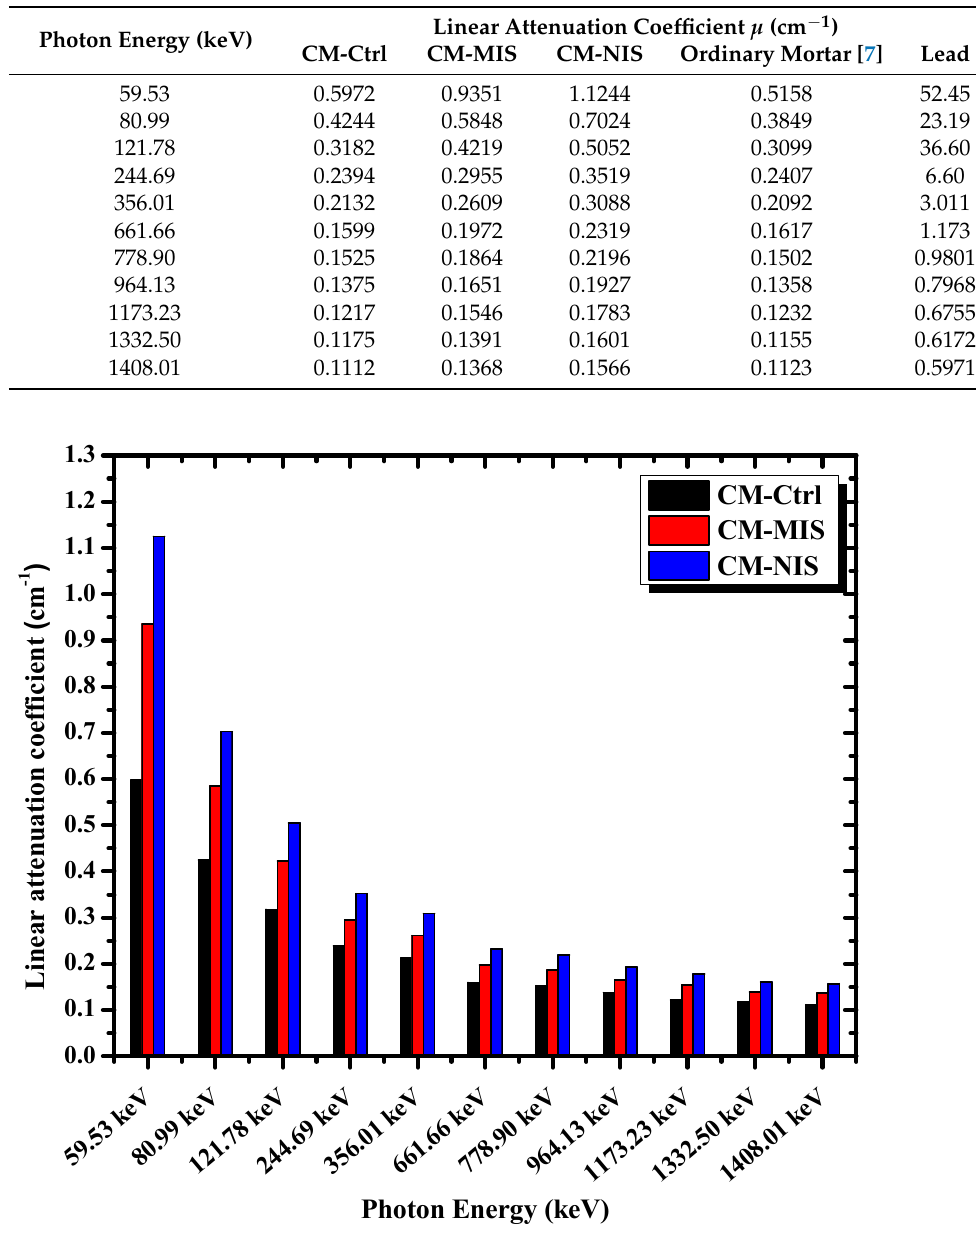
Table 4. The values of LACs of the tested mortars in addition to lead.